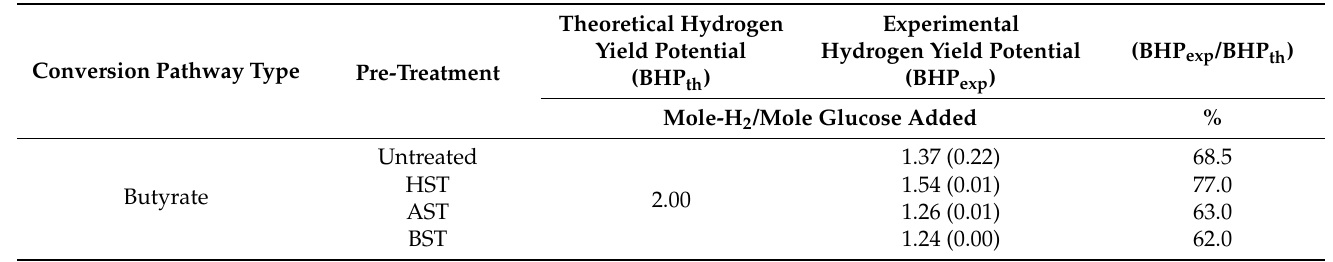
Table 6. Comparison between experimental hydrogen potential (BHP exp ) and theoretical hydrogen potential (BHP th